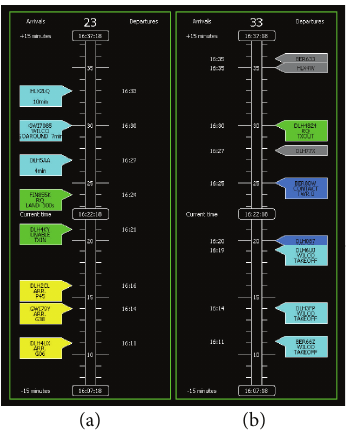
Figure 13: Simulated arrival/departure manager. The timeline for RW23 is on (a); the timeline for RW33 is on (b). The top of the timeline is 15 minutes in the future; the bottom is 15 minutes in the past. Arriving aircraft are displayed on the left of timeline (a) and departing aircraft on the right of the timeline (b).